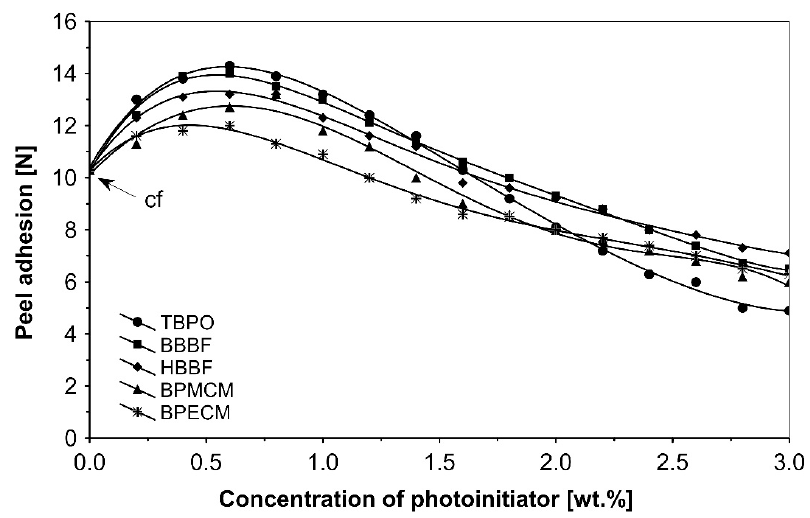
Figure 3. Influence of multifunctional photoinitiators on the peel adhesion of a UV-crosslinked acrylic PSA.